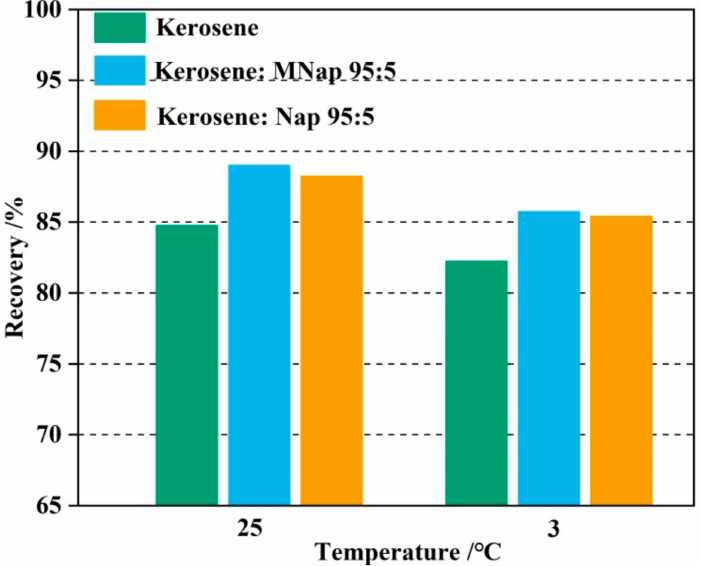
Figure 8. The effect of mass ratio of kerosene to Nap on molybdenite flotation (collector 170 g/t, frother 90 g/t).